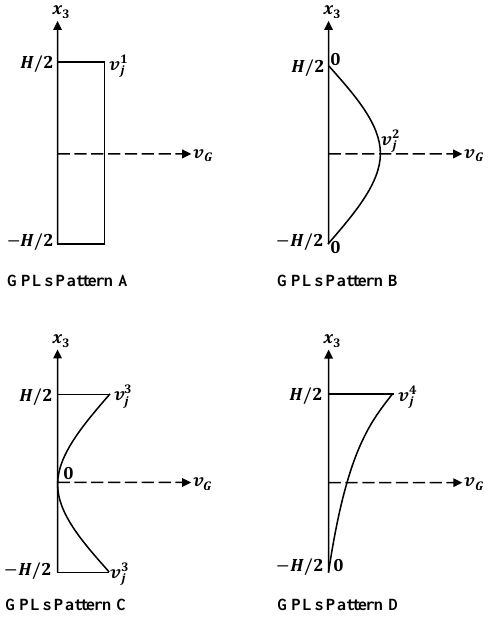
Figure 3. GPLs distribution